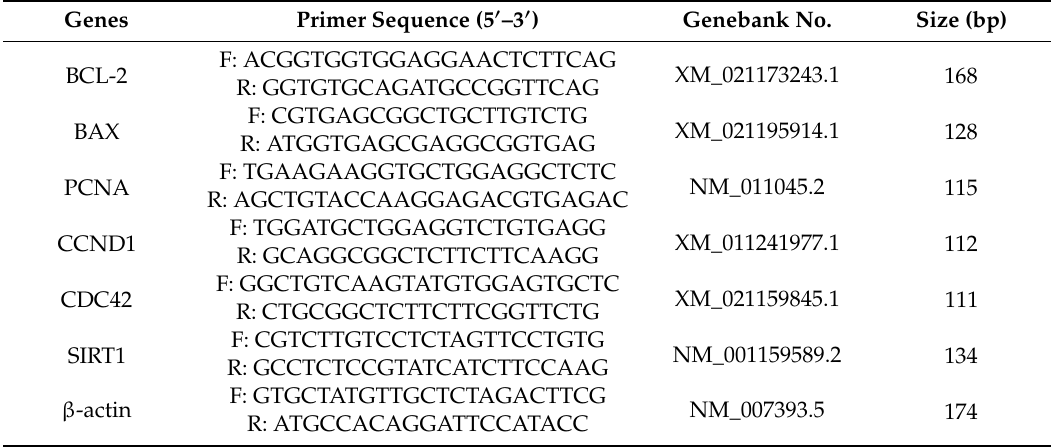
Table 1. Information on primers of real-time quantitative PCR.